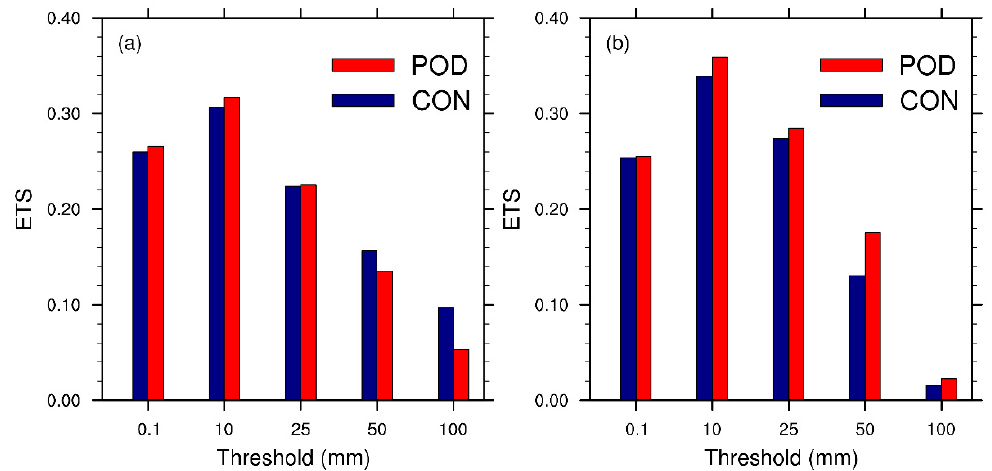
Figure 7. The average Equitable Threat Score (ETS) of 24-h accumulated rainfall. The scores in ( a ) are obtained from 2016 statistics, and ( b ) from 2017 statistics.